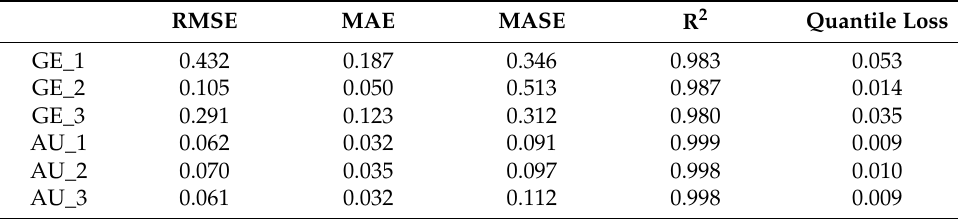
Table 8. TFT performance for the 6